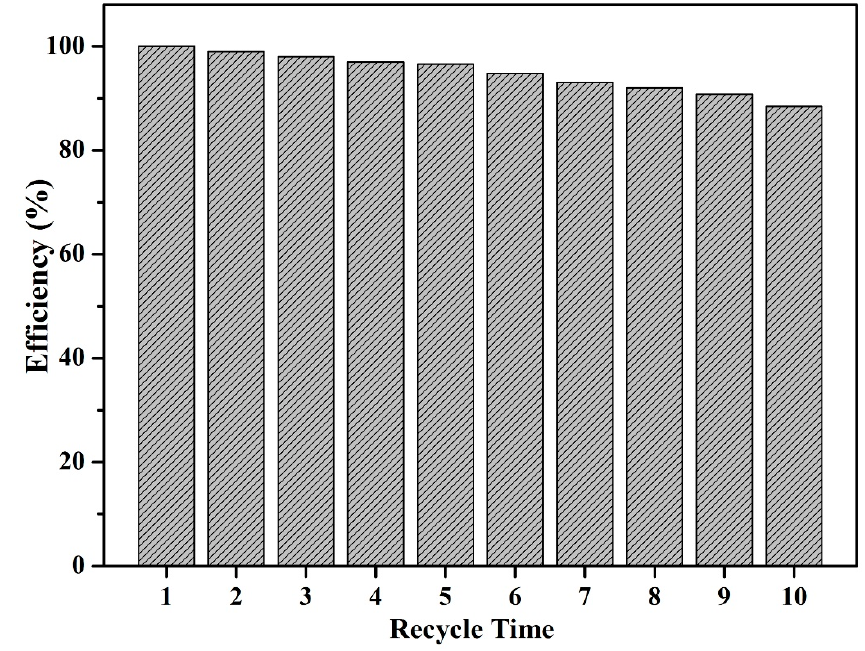
Figure 11. MB adsorption capacities of MnO-4 in 10 adsorption cycles. Table 3. Comparison of the adsorption capacities of different absorbents from previous reports with that of C,